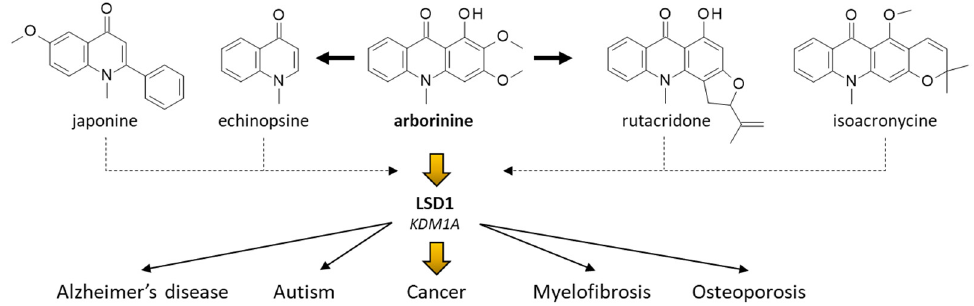
Figure 6. Structural analogy between arborinine and other bi, tri or tetracyclic alkaloids with a 1-methylquinolin-4-one (echinopsine) unit. These compounds represent potential LSD1 inhibitors, which may be used to treat diverse human diseases, such as those indicated.